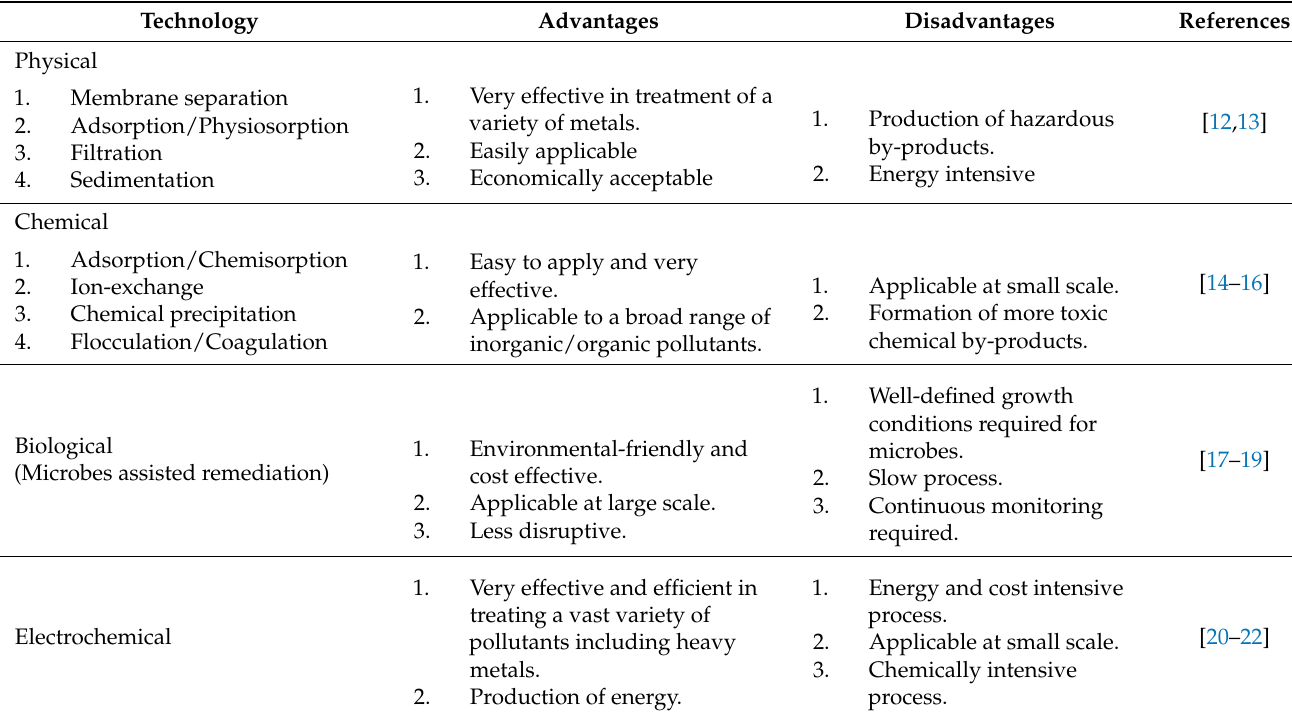
Table 1. Conventional approaches for the remediation of heavy metals and their associated advantages and